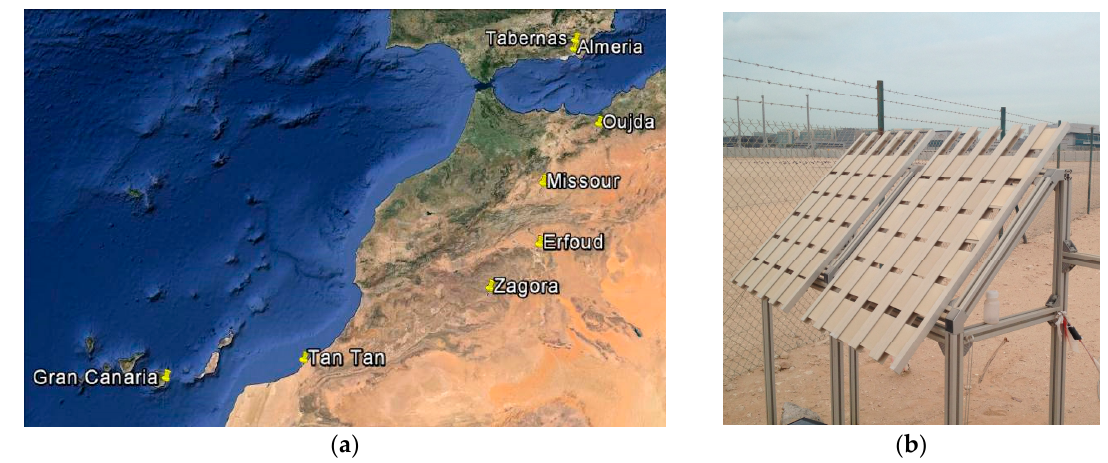
Figure 2. Exposure sites in North Africa and Spain ( a ); typical exposure rack ( b ).